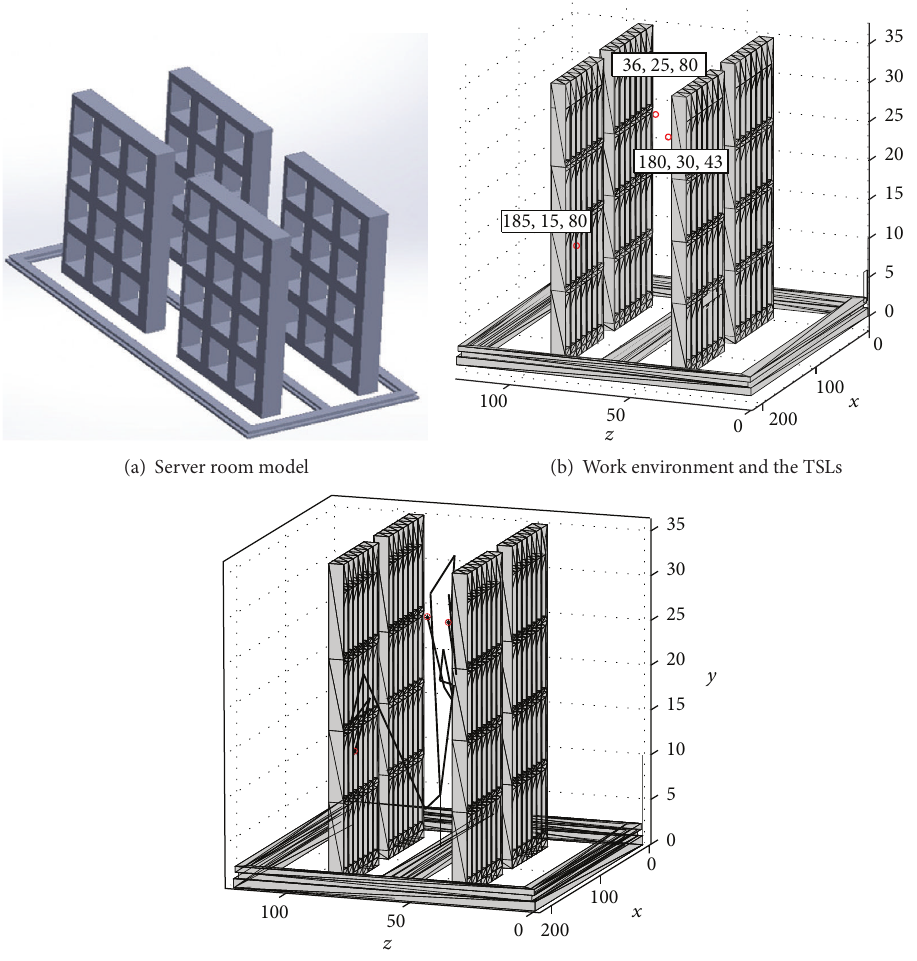
Figure 8: A server room case